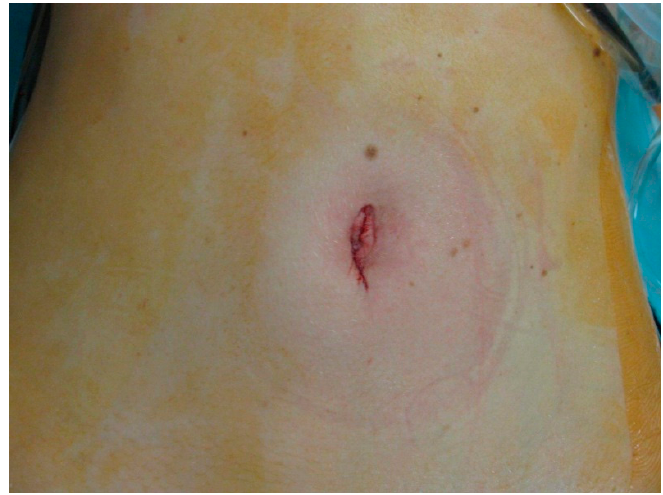
Figure 1. Image of the abdominal scar following single ‐ port (SP) major hepatectomy (resections of segments VII and VIII).